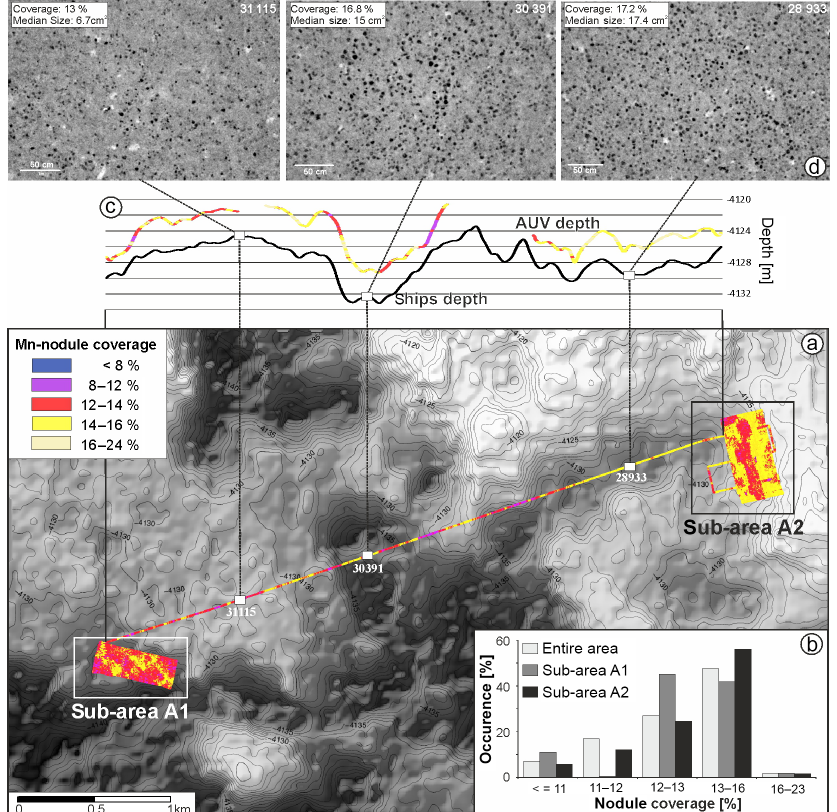
Figure 5. (a) Bathymetric map (ship-based MBES) of the working area with nodule coverage calculated from AUV photo survey; the photo examples in panel (d) show the Mn-nodule coverage and median size in different areas. (b) Statistical evaluation of nodule coverage for the entire photo survey (green bars; 30038 photos) and the sub-areas A1 (grey bars; 10120 photos) and A2 (red bars; 16890